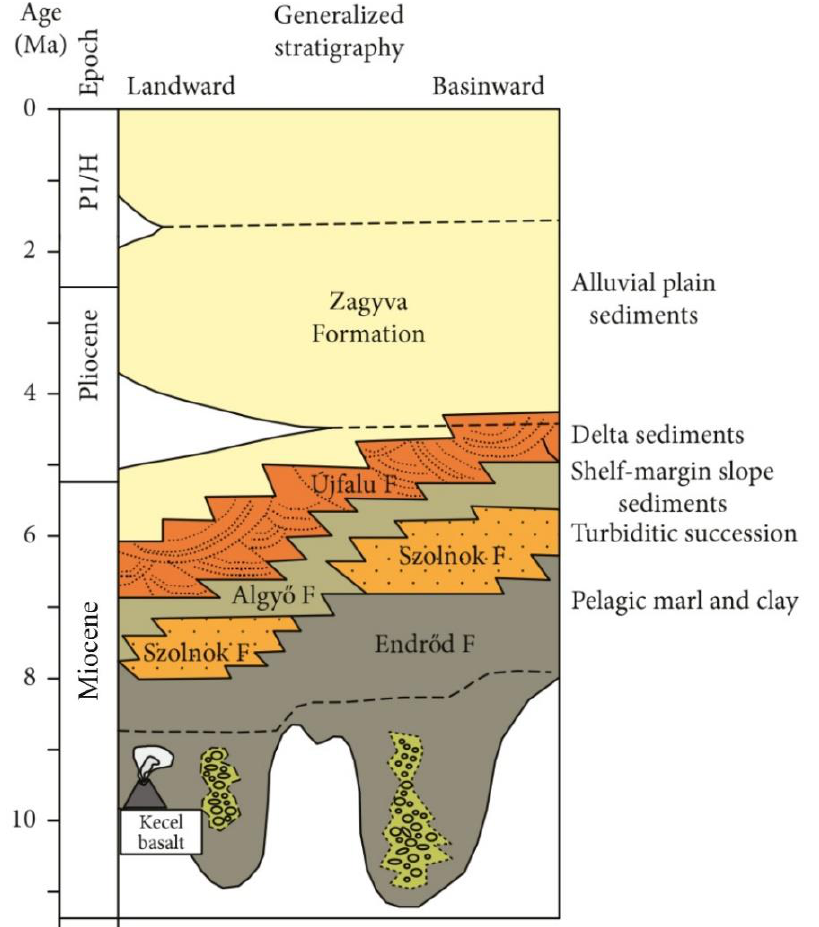
Figure 2. Generalised chrono- and lithostratigraphy of the Miocene – Holocene deposits in the study area simplified after [27]. Abbreviations: Pl = Pleistocene; H = Holocene [11].